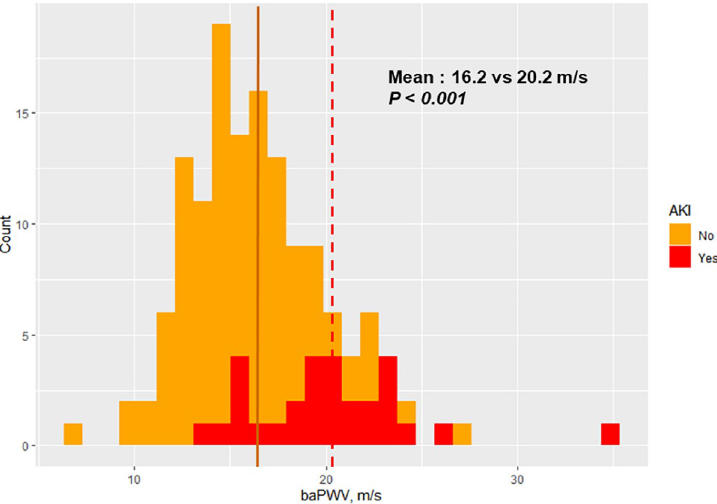
Fig 2. Comparison of distributions of baPWV data between patients with and without acute kidney injury. Solid line = mean baPWV of patients without AKI, dotted line = mean baPWV of patients with AKI. AKI, acute kidney injury; baPWV, brachial-ankle pulse wave velocity.